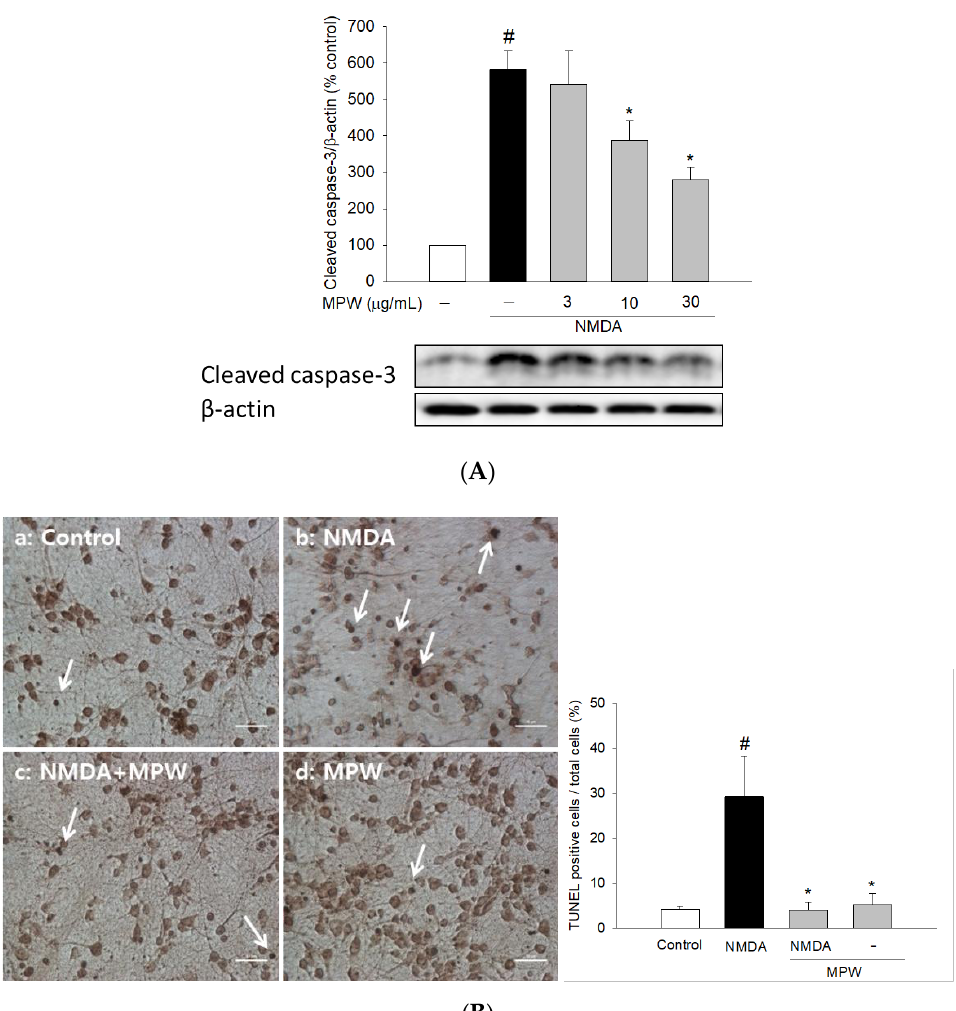
Figure 4. Effects of MPW on NMDA-induced caspase 3 activation and DNA fragmentation in primary rat cortical cells. ( A ) The cultured cells were treated with 100 μM NMDA for 12 h in the absence or presence of MPW at 3, 10, and 30 μg/mL. The level of cleaved caspase 3 was assessed by Western blotting, as described in the Materials and Methods. A representative blot from three independent experiments is shown. ( B ) The cultured cells were treated with 100 μM NMDA for 2 h in the absence or presence of MPW at 30 μg/mL, and then the TUNEL assay was carried out. Representative microscopic images from at least three independent experiments are shown. Cells were treated with the vehicle (a), NMDA (b), NMDA and MPW (c), or MPW alone (d), respectively. The representative TUNEL-positive cells are indicated by white arrows. Scale bar = 10 μm. Each data point represents the mean ± S.E.M. from at least three independent experiments (#, p < 0.05 vs. the vehicle-treated control cells without MPW; *, p < 0.05 vs. the NMDA-treated cells without MPW).